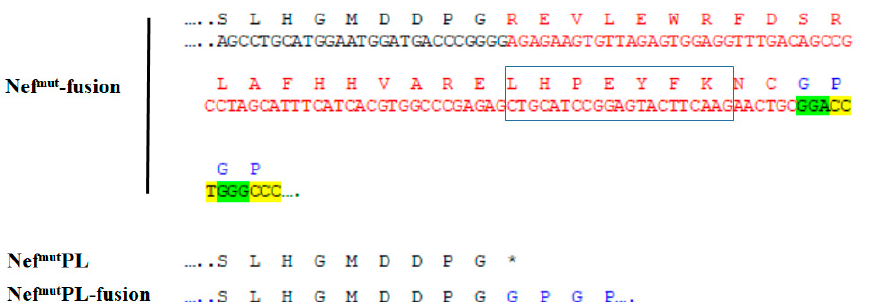
Figure 1. Nef C-terminal sequences in both Nef mut PL and Nef mut PLfusion DNA vectors. On the top, both nucleotide and amino acid sequences at the C-terminus of Nef mut ORF in the context of both pTargeT- and pVAX1-Nef mut fusion vectors are reported. Sequences just before the truncation are in blue, sequences of the 29-amino acid region deleted in the Nef mut PL ORF are in red, and the linker sequence is in green/yellow. The CRM domain is highlighted. At the bottom, amino acid sequences of Nef C-terminal regions in both Nef mut PL and Nef mut PLfusion vectors are reported. In the latter case, the position of the GPGP linker is indicated. * marks the stop codon.